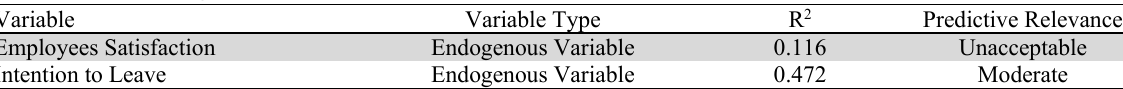
R 2 Values for the Endogenous Variables